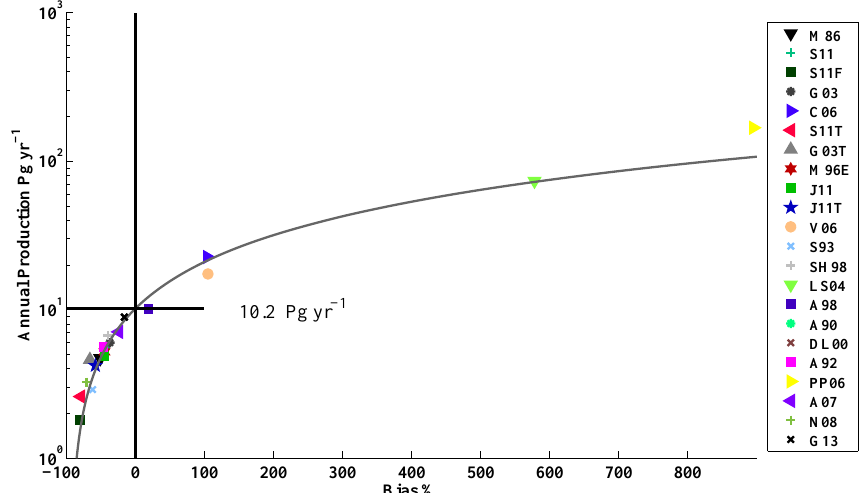
Fig. 8. Global annual SSA mass production plotted against the bias of modeled vs. observed PM 10 and EMEP concentrations. The fitted curve is the first-order linear fit to the data. The intersection of the fitted curve with the zero bias line yields a best estimate of global annual PM 10 emissions of 10.2Pgyr − 1 . DL00 is outside the plotted range. For acronyms in the legend, see Table